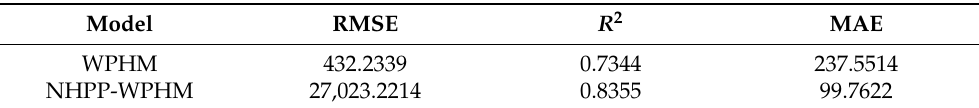
Table 9. RMSE, R 2 , and MAE before the first repair.